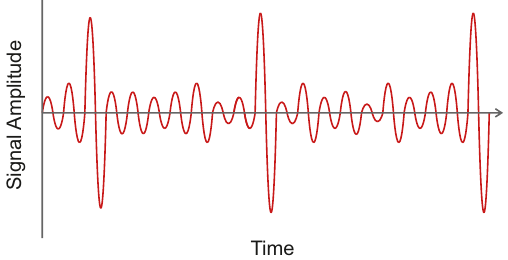
Figure 1. Example of a high peak-to-average power ratio signal in the time